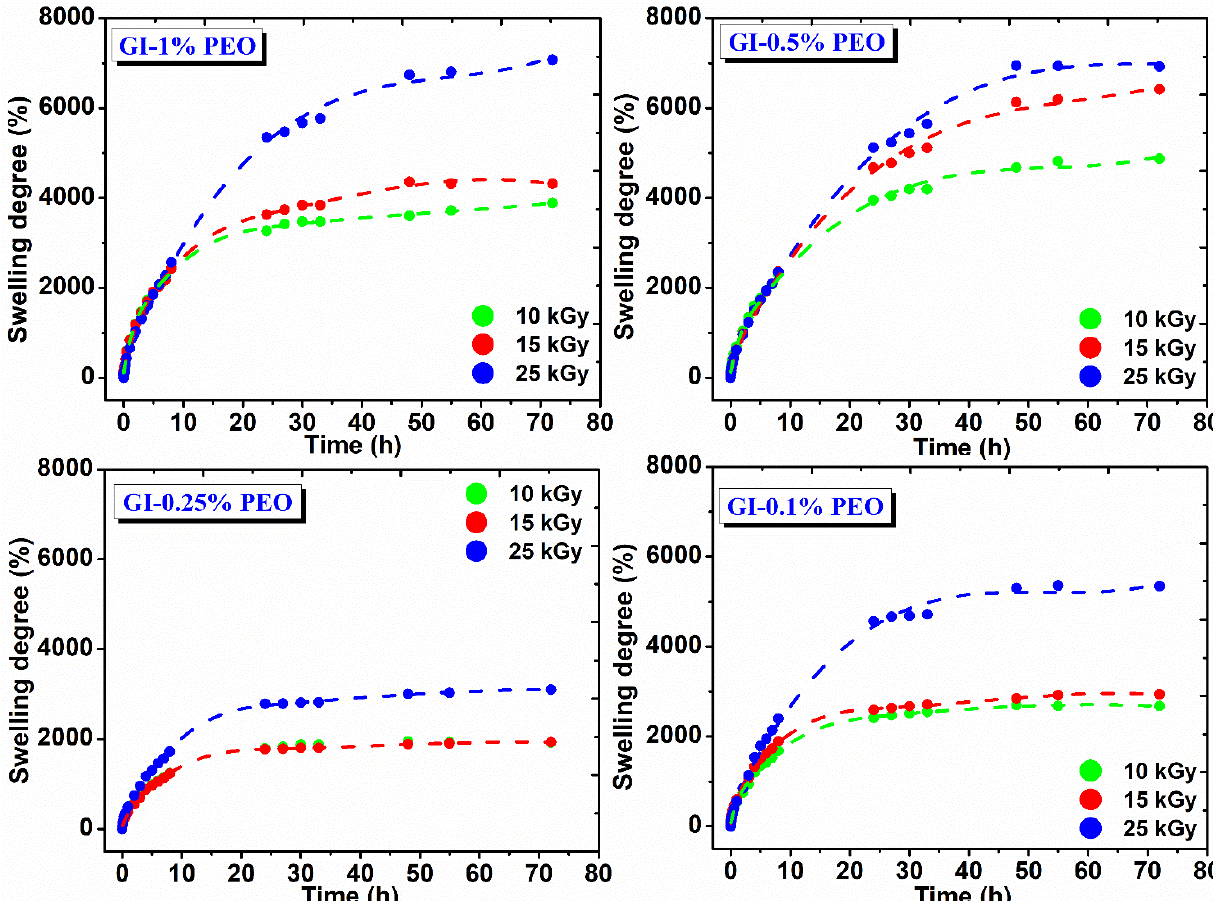
Figure 5. Swelling degree in DI water for hydrogels prepared with (0.1–1)%